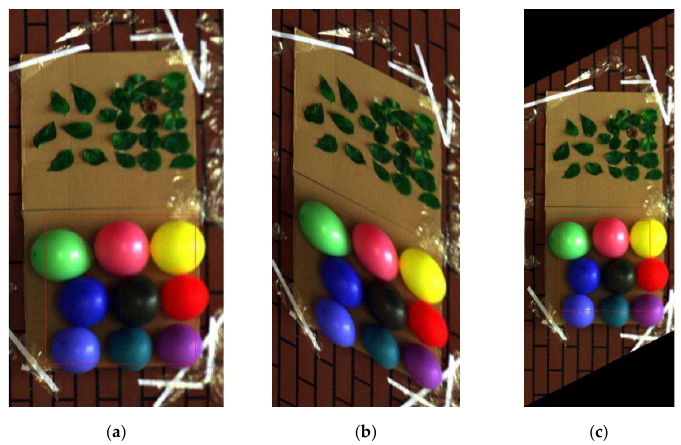
Figure 7. Image acquired by normal or tilting sampling. ( a ) Normal image; ( b ) tilting image; ( c ) tilting image after geometric correction.